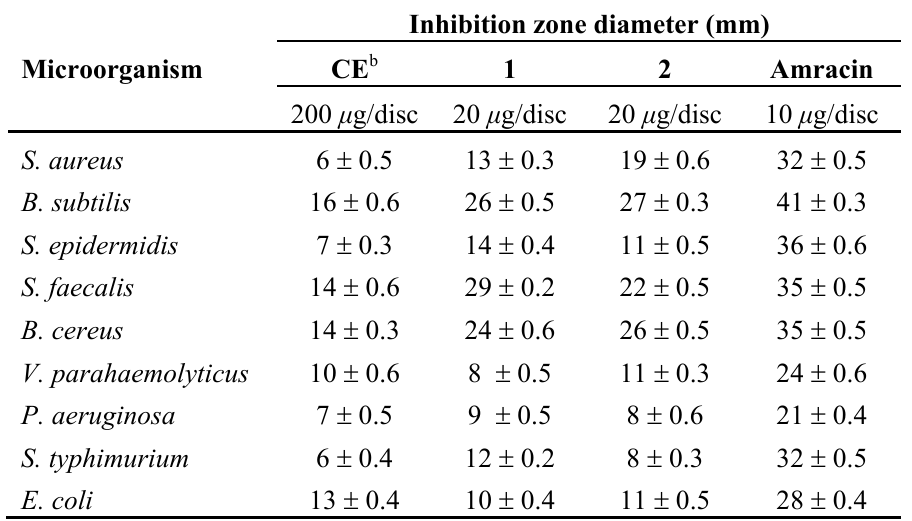
Table 2. Antimicrobial activities of 70% methanolic extract and isolated compounds a